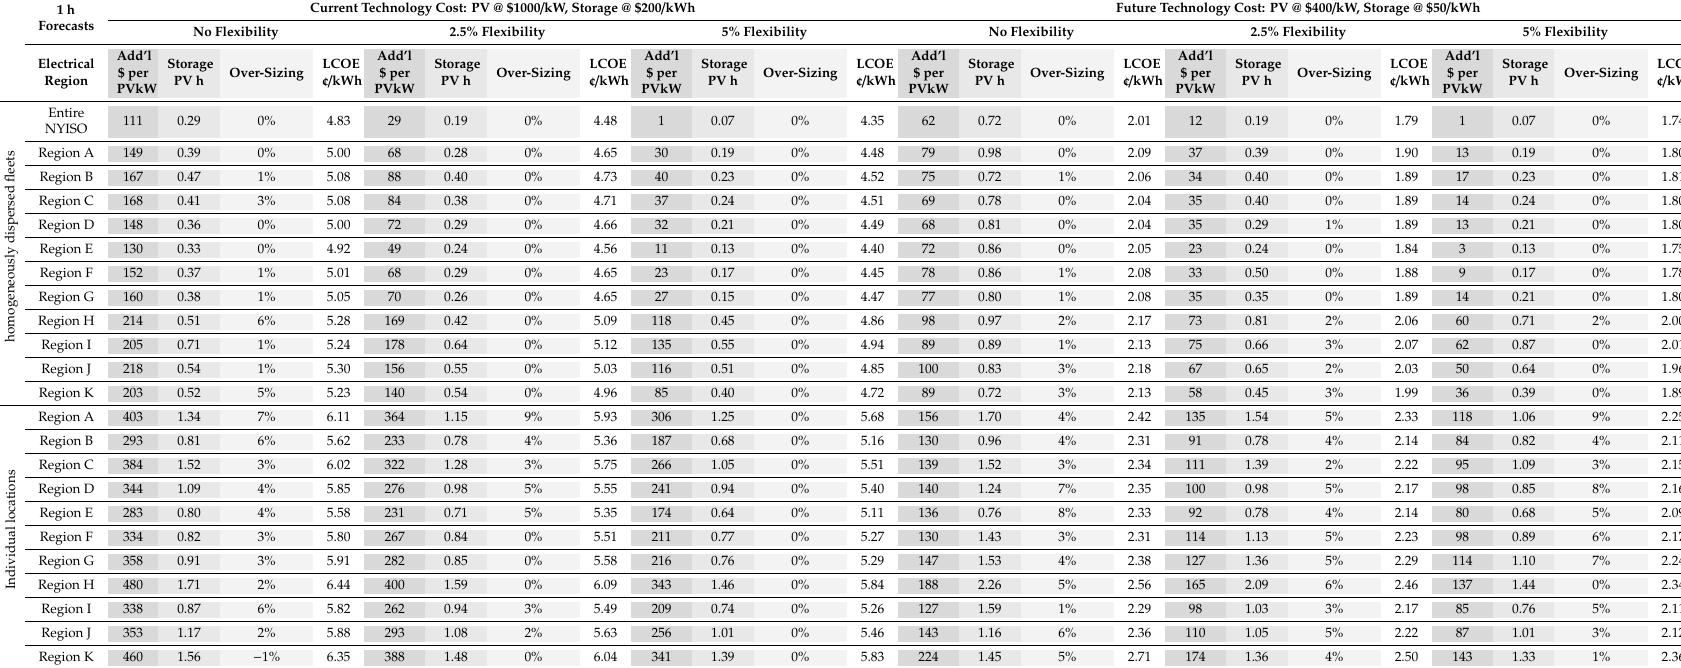
Table 1. One-hour-ahead